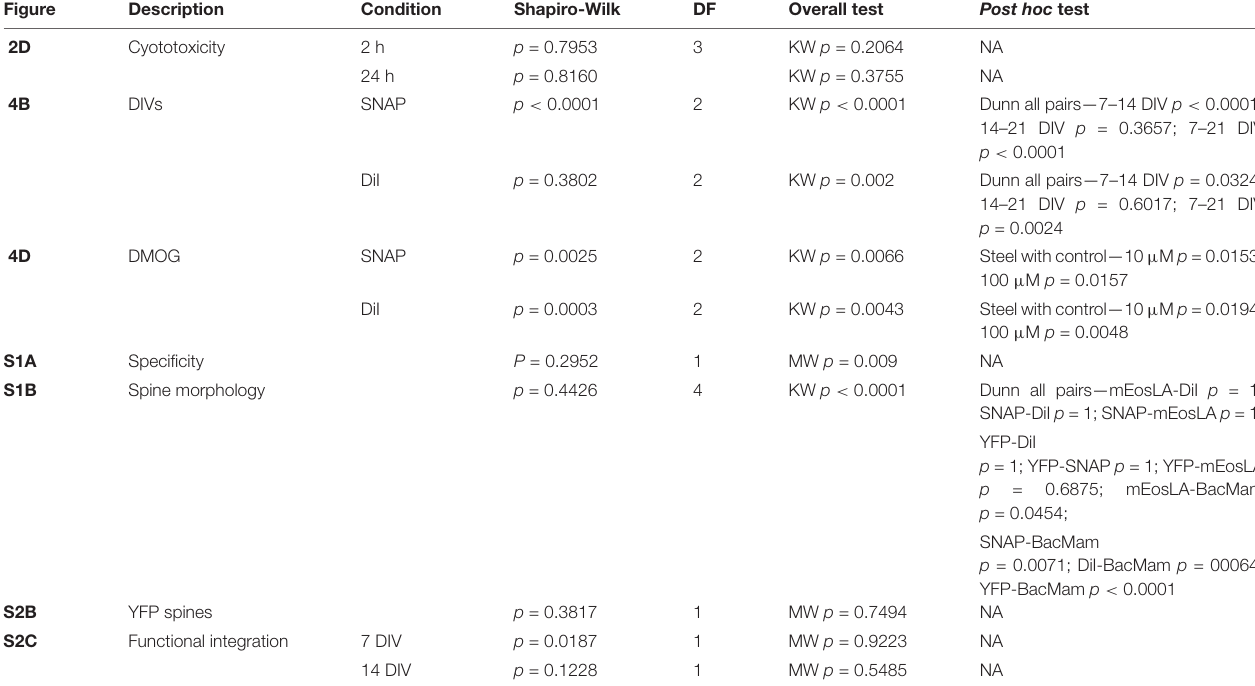
TABLE 1 | Detailed statistics for the executed experiments. Figure Description Condition